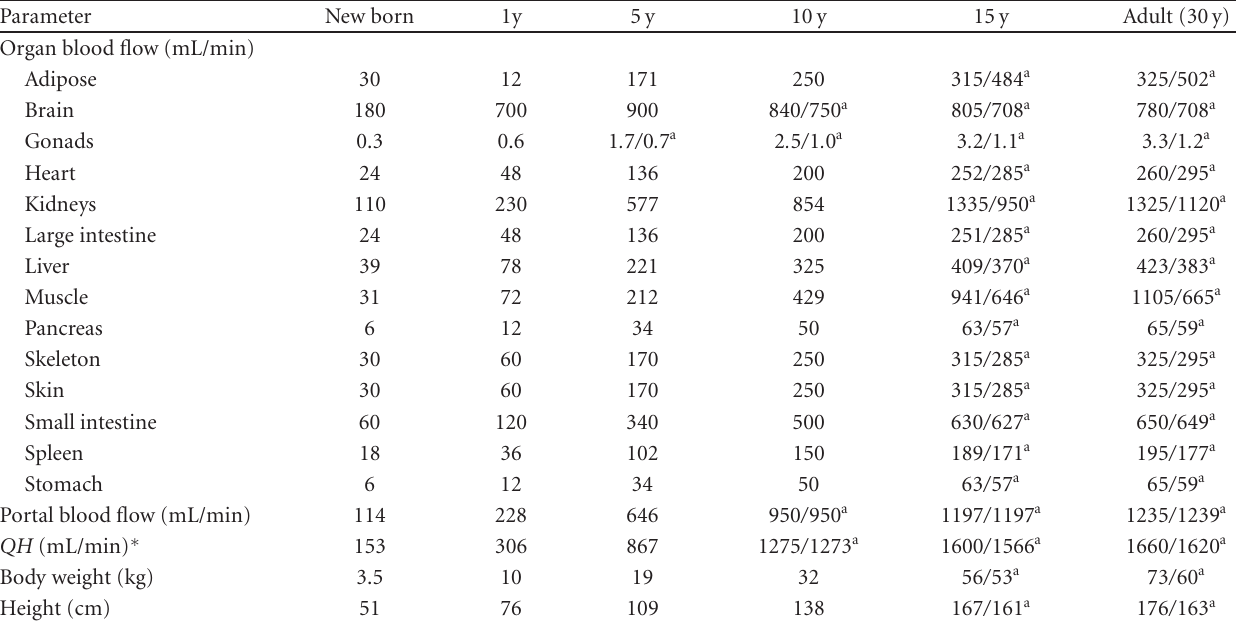
Figure 5: Simulated midazolam maternal plasma concentration-time profile following postcaesarean IV bolus compared with two di ff erent set of observed data; adapted from Andrew et al. [32]. Table 2: Values of organ blood flows, portal blood flow, total hepatic blood flow ( QH ), bodyweight, and height that were used in the PBPK model developed and reported by Edginton et al.